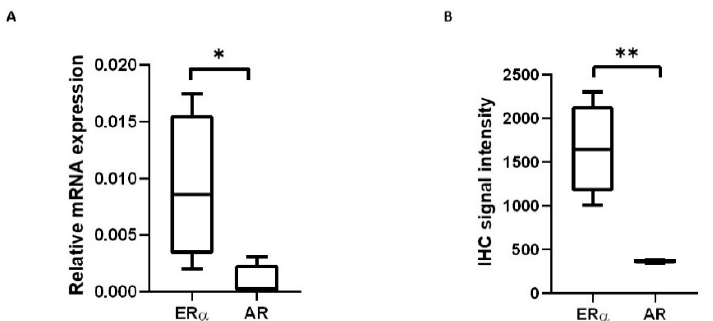
Figure 7. Comparison of mRNA and protein expression of ER α and AR in selected human lacrimal gland samples. ( A ) Box plot showing significantly higher mRNA expression of ER α than AR in lacrimal gland samples. ( B ) Box plot showing significantly higher ER α than AR IHC signal intensity in lacrimal gland samples. * p < 0.05, ** p < 0.01.